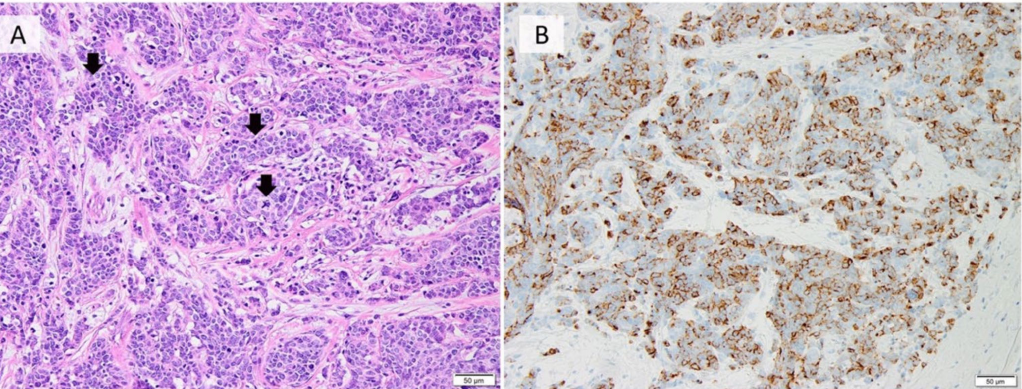
Figure 3. Morphological and immunohistochemical features of NEC of the breast. Neuroendocrine carcinoma (NEC) of the breast showing infiltrative, densely packed hyperchromatic cells with a high nuclear-to-cytoplasmic ratio. Mitotic figures are seen (arrows). ( A ) H & E staining ( × 200); ( B ) positive immunostaining for chromogranin A ( × 200) (Pictures by